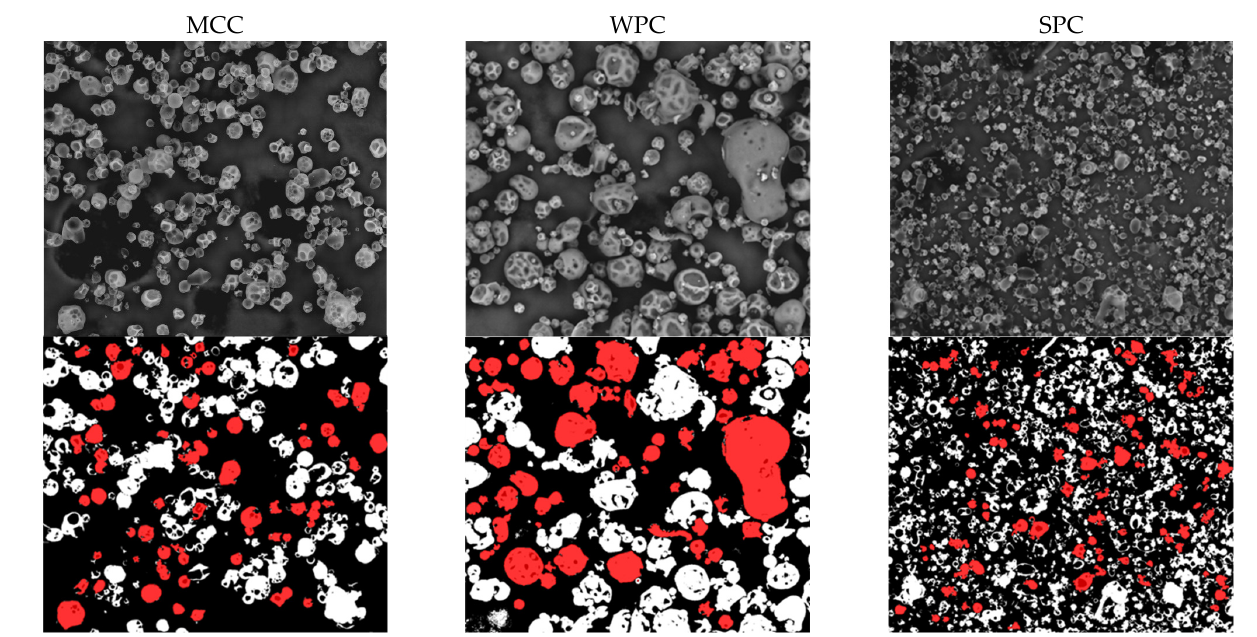
Figure 3. Examples of micrographs for fractal dimension calculations.